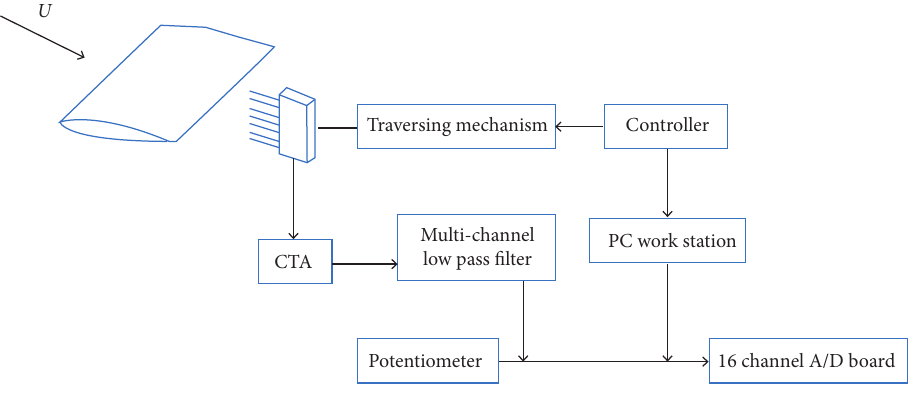
Figure 5. Block diagram of data acquisition system.